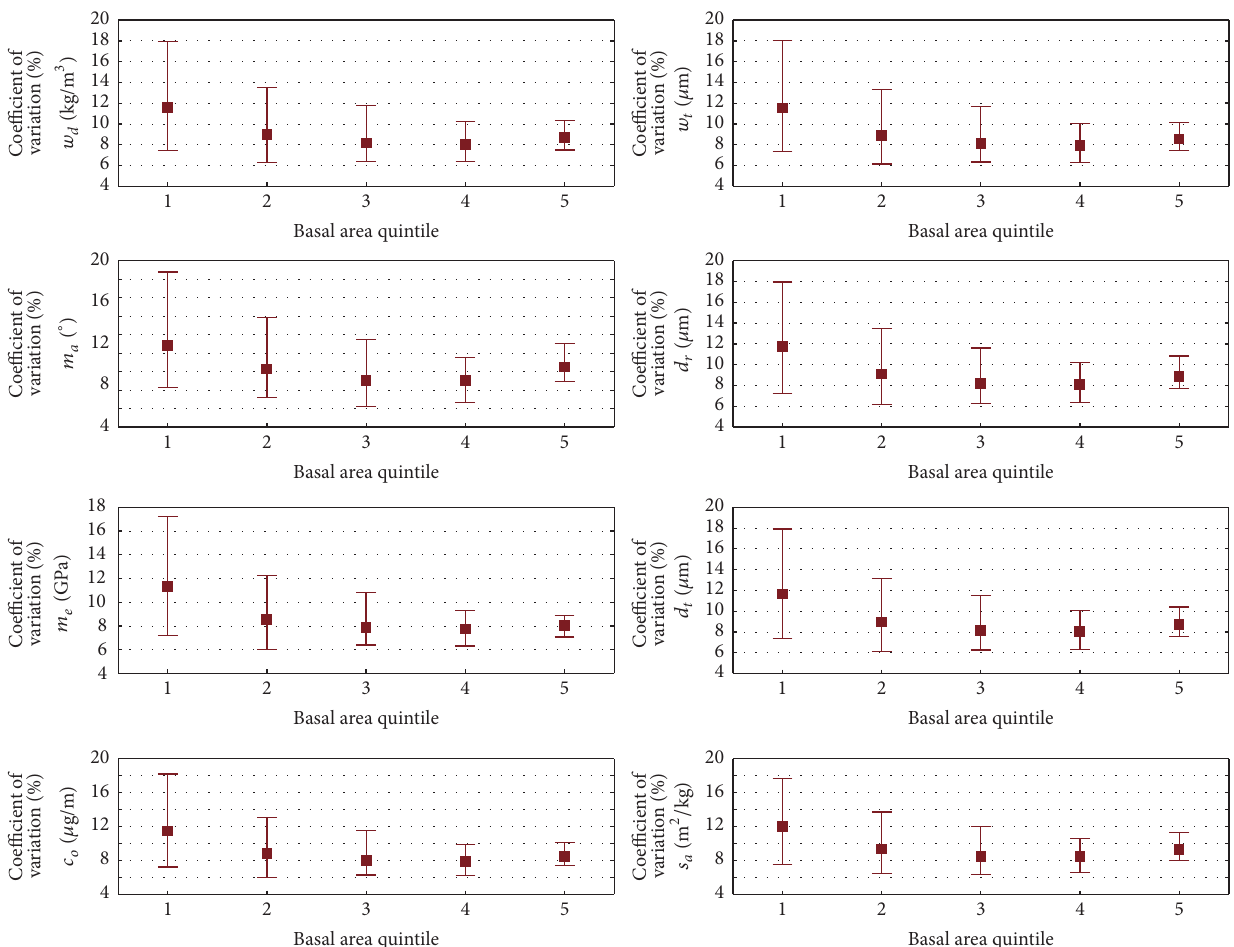
Figure 3: Fibre attribute variation as measured by the coefficient of variation by size quintile. Note: ( 1 ) the solid square denotes the mean value whereas the lower and upper whiskers denote minimum and maximum values, respectively, and 𝑤 𝑑 , 𝑚 𝑎 , 𝑚 𝑒 , 𝑐 𝑜 , 𝑤 𝑡 , 𝑑 𝑟 , 𝑑 𝑡 , and 𝑠 𝑎 are abbreviative notation for wood density, microfibril angle, modulus of elasticity, fibre coarseness, tracheid wall thickness, radial tracheid diameter, tangential tracheid diameter, and specific surface area,